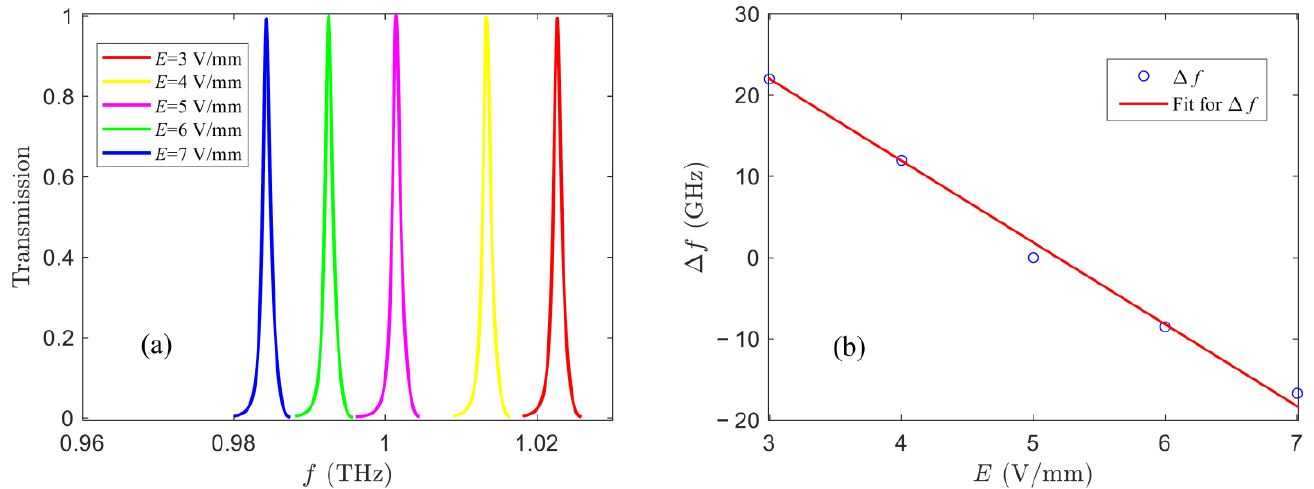
Figure 4. Electrically tuning of the narrow band THz filter. ( a ) Transmission peak shifting with the external electric field; ( b ) peak frequency shift of the filter and its best fit denoted by the blue circles and solid red line, respectively.